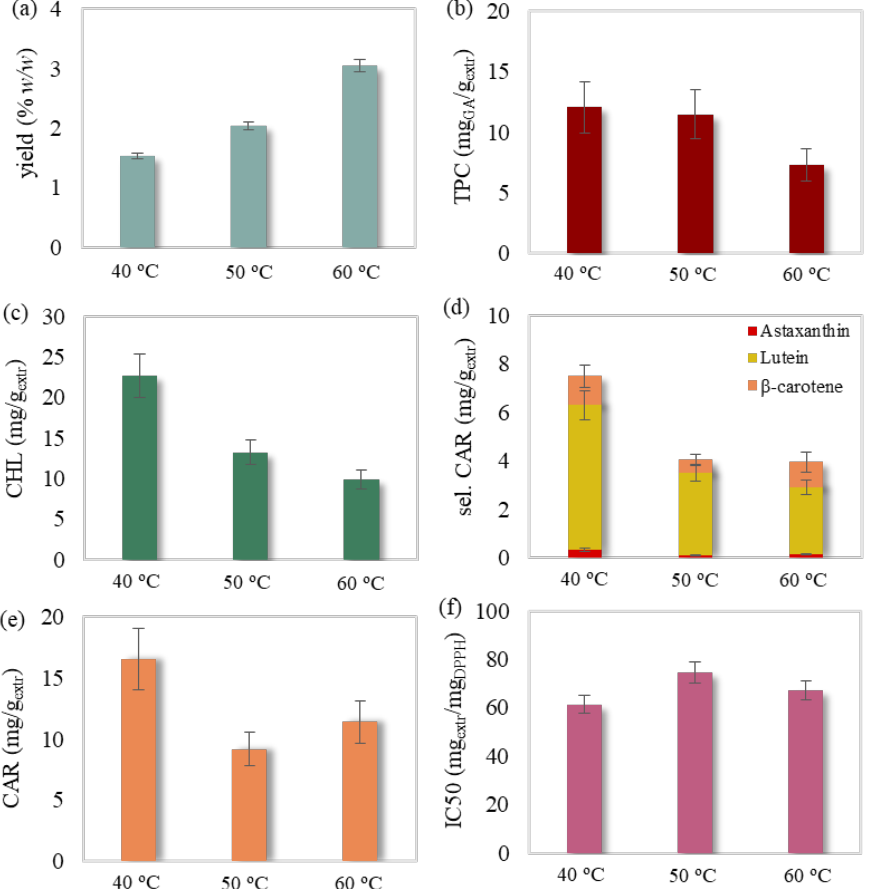
Figure 2. Temperature effect on SFE’s ( a ) yield, ( b ) total phenolic, ( c ) chlorophyll, ( d ) selected carotenoid, ( e ) total carotenoid content and ( f ) antioxidant activity examined at a pressure of 180 bar and a solvent flow rate of 30 g/min. The presented error bars express the standard deviation percentage of the central point replicates.